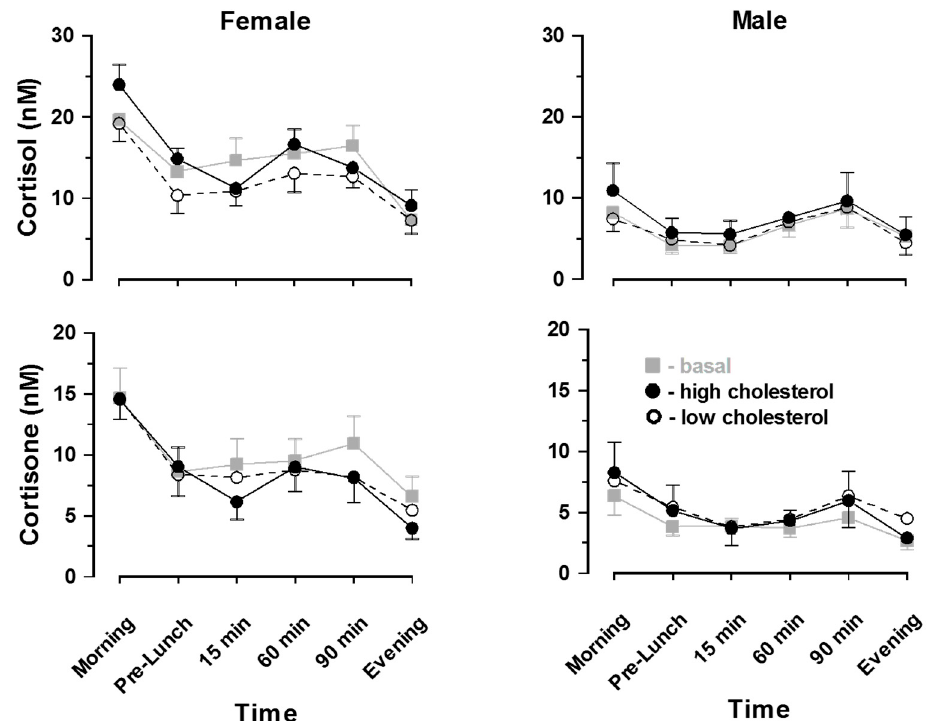
Figure 2. Salivary cortisol and cortisone values (mean ± SEM) showed expected diurnal variation with more marked increases in cortisol than cortisone. Female compared to male values were similar for cortisol, lower for cortisone and higher for cortisol:cortisone ratios ( p < 0.01, see Table 2). Table 2. Effects of sex and meals on salivary cortisol: cortisone ratio values in male and females. Female Cortisol:Cortisone Collection Time